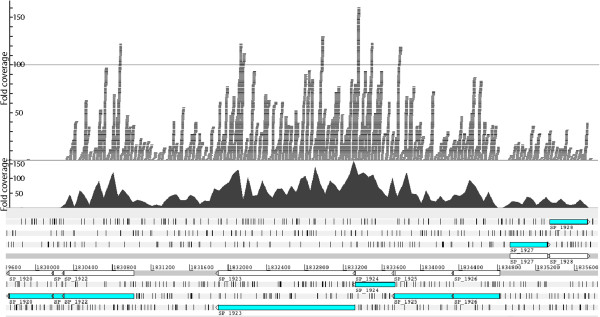
Characterization of SP_1922. RNA-Seq expression coverage of SP_1922 and neighboring regions drawn using Artemis [62]. RNA-Seq reads from TIGR4 adherent samples were mapped onto the TIGR4 genome. Predicted genes are shown in cyan on the bottom panel that displays the six frames of translation. Grey bars on the top panel represent RNA-Seq reads and the black plot below them represents the amount of read coverage, which is proportional to expression levels. The coverage plot across genes SP_1922 - SP_1926 is uninterrupted, indicating that these genes are likely to be expressed as an operon.